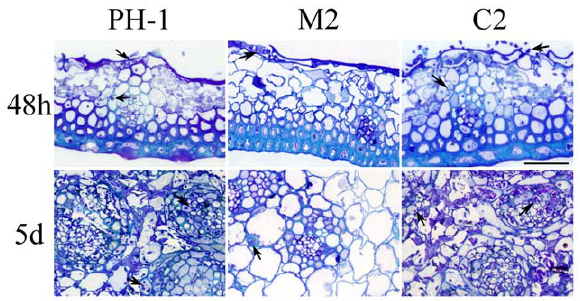
Figure 3. Colonization of flowering wheat heads. A. Colonization of glume tissues by the wild-type (PH-1), D amt1 mutant (M2), and D amt1/AMT1 (C2) strains 48 hpi. B. The rachises directly beneath the inoculated spikeletes were examined 120 hpi. Hyphae growth (marked with arrows) was abundant in plant tissues inoculated with the wild type and D amt1/AMT1 strains but scarce in samples inoculated with